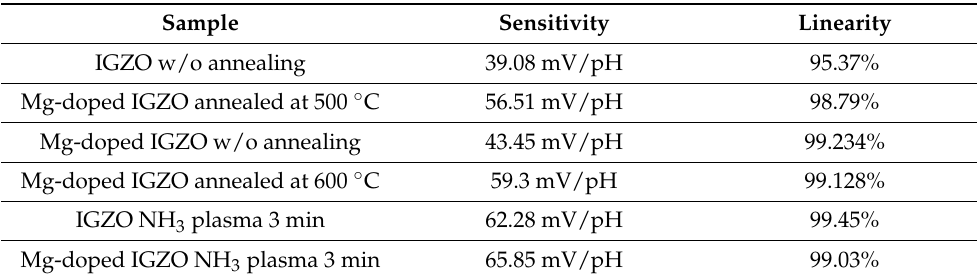
Table 1. Comparison of InGaZnO and Mg doped InGaZnO samples with annealing at 500 ◦ C and NH 3 plasma treatment for 3